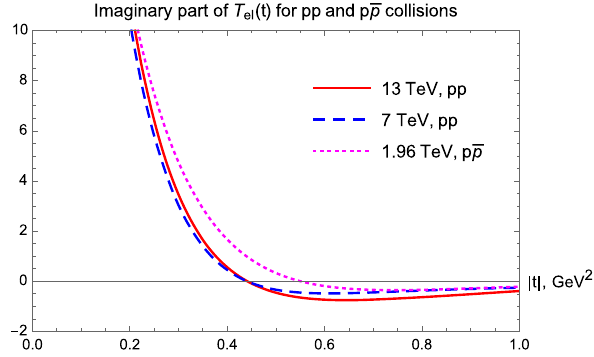
Fig. 16 Real part of the elastic scattering amplitude as a function of t for three distinct energies of pp and p ¯ p collisions